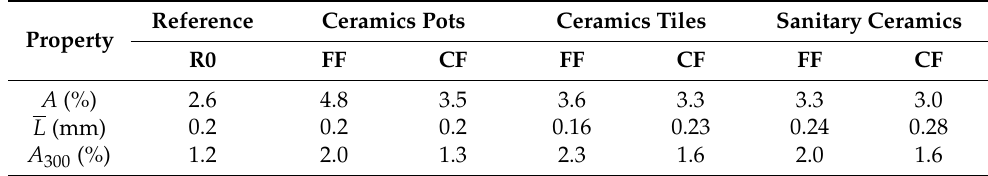
Table 7. The characteristics of the air pores in the hardened